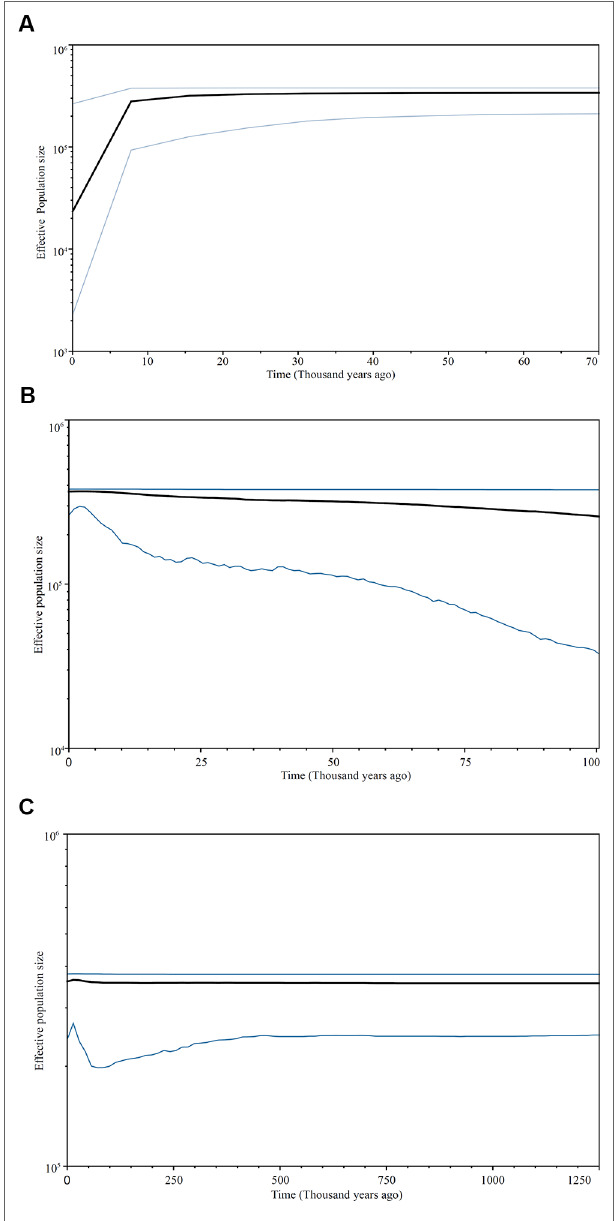
FIgUrE 4 | Bayesian skyline plots based on cpDNA (A) and single-copy nDNA: EX (B) and FJ (C) . The X -axis indicates time in thousands of years ago and the Y -axis represents the effective size multiplied by generation time on a log scale. The black line indicates the estimated median and the area between the blue lines represents the 95% confidence